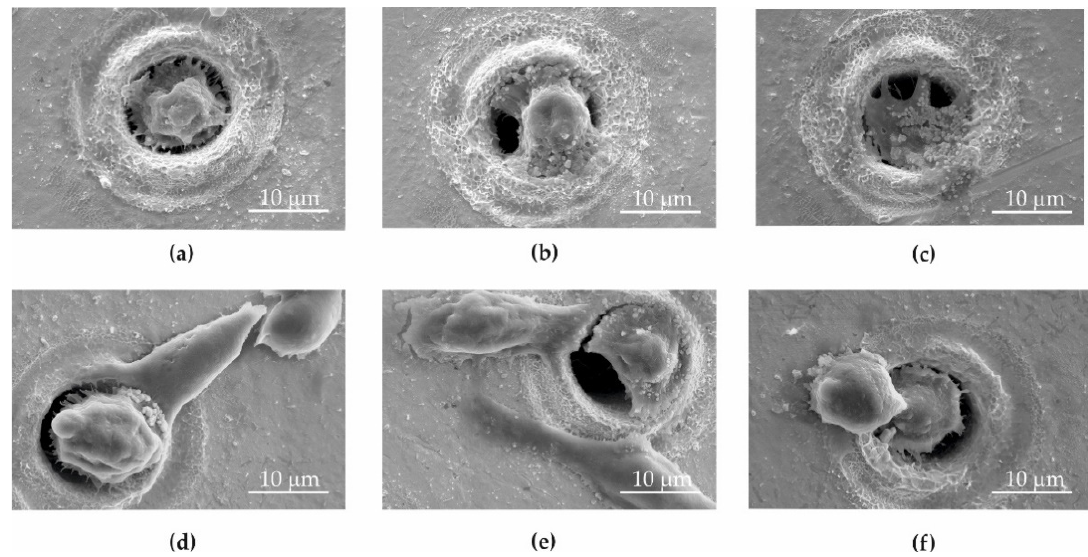
Figure 3. SEM image of the DU 145 cells on Au ( a – c ) sieve and Au + GO ( d – f ) sieves.